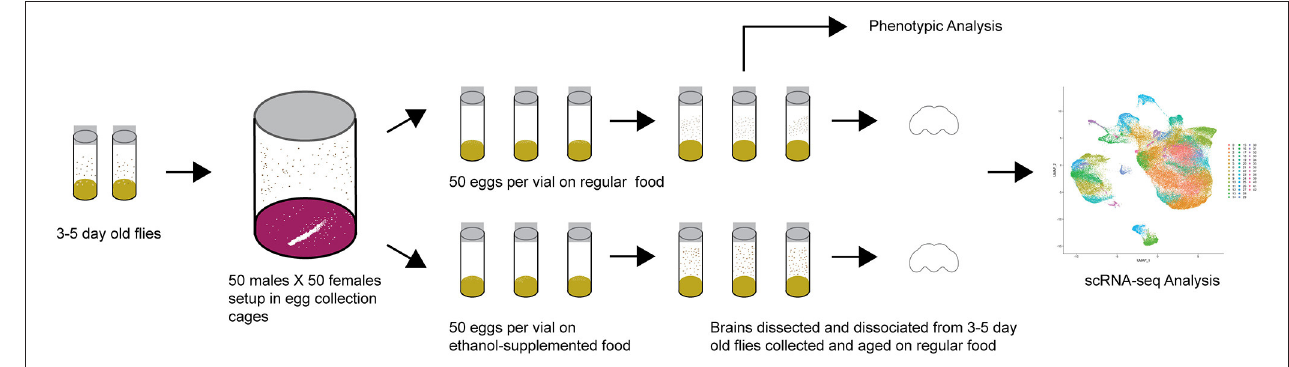
FIGURE 1 | Diagram of the experimental